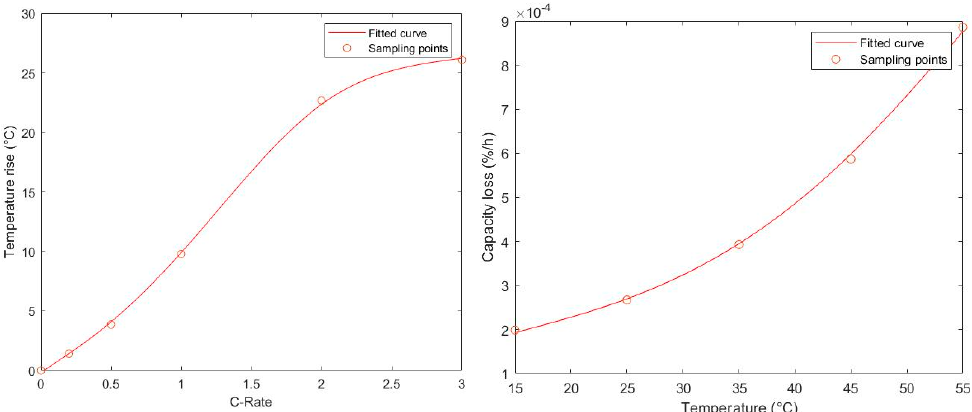
Figure 9. Fitted curve for the temperature increase inside an LIB at different C ‐ Rates ( left ) (based on [37]), and for the permanent capacity loss in dependency to LIB cell temperatures ( right ) (based on [38]).